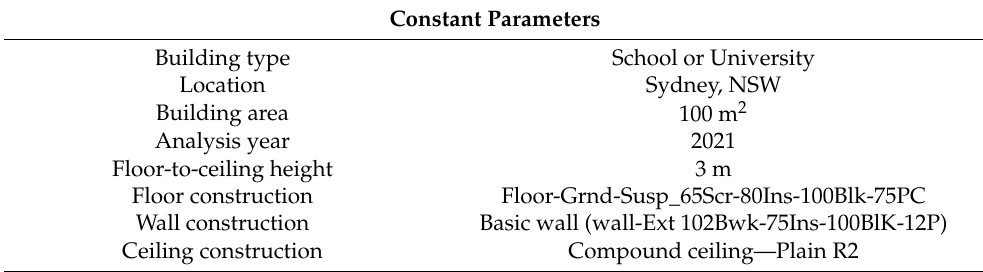
Table 2. Summary of model constant